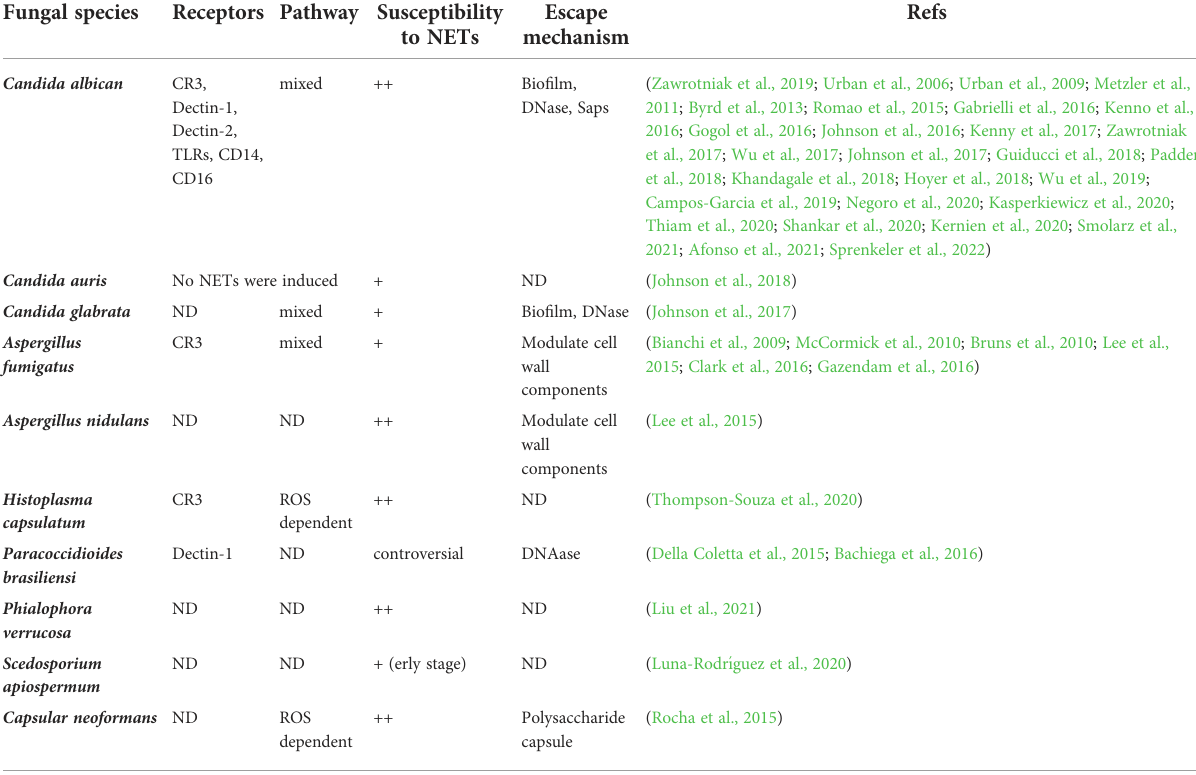
TABLE 1 Summary of different fungi interactions with neutrophil extracellular traps